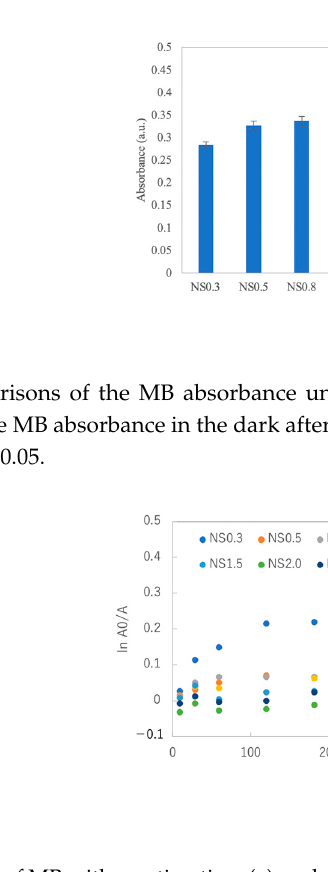
Figure 4. Time course of the decolorization of methylene blue in the presence of prepared titania samples . ( a ) MB decolorization under UV irradiation. ( b ) MB decolorization in the dark.